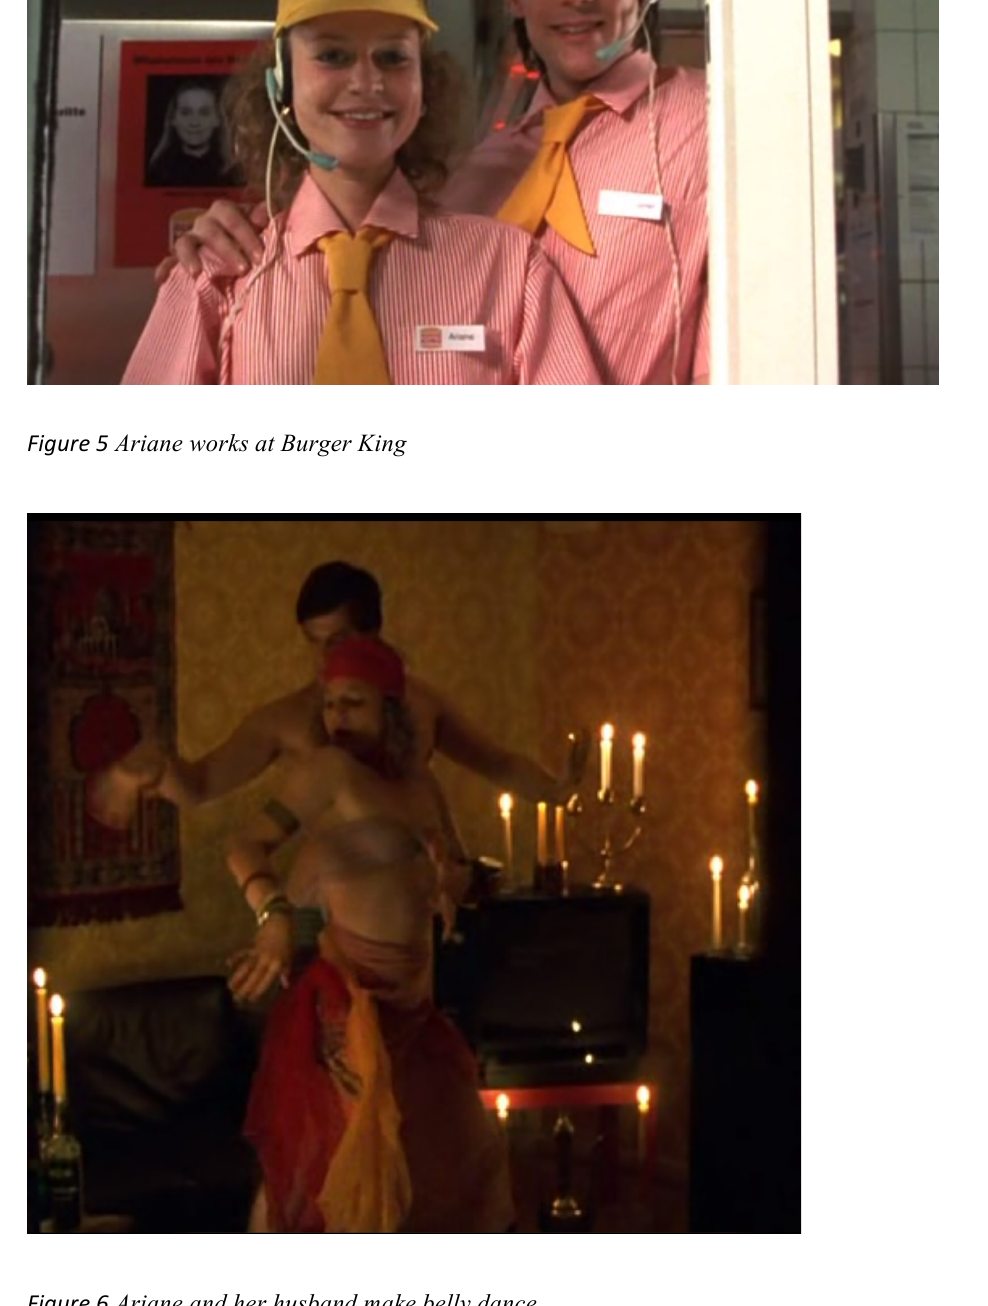
Figure 6 Ariane and her husband make belly